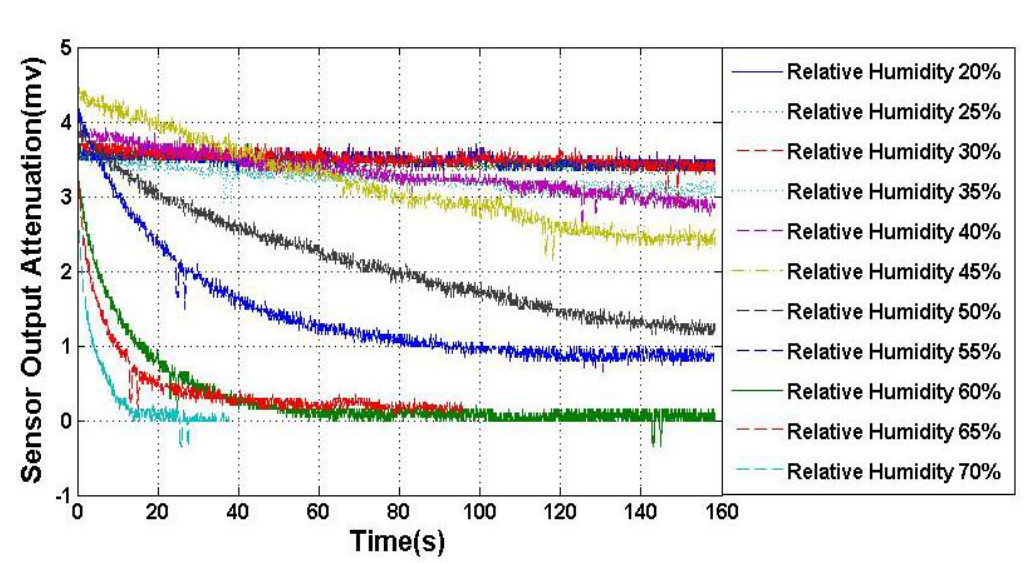
Figure 5. Sensor output caused by field attenuation before package surface